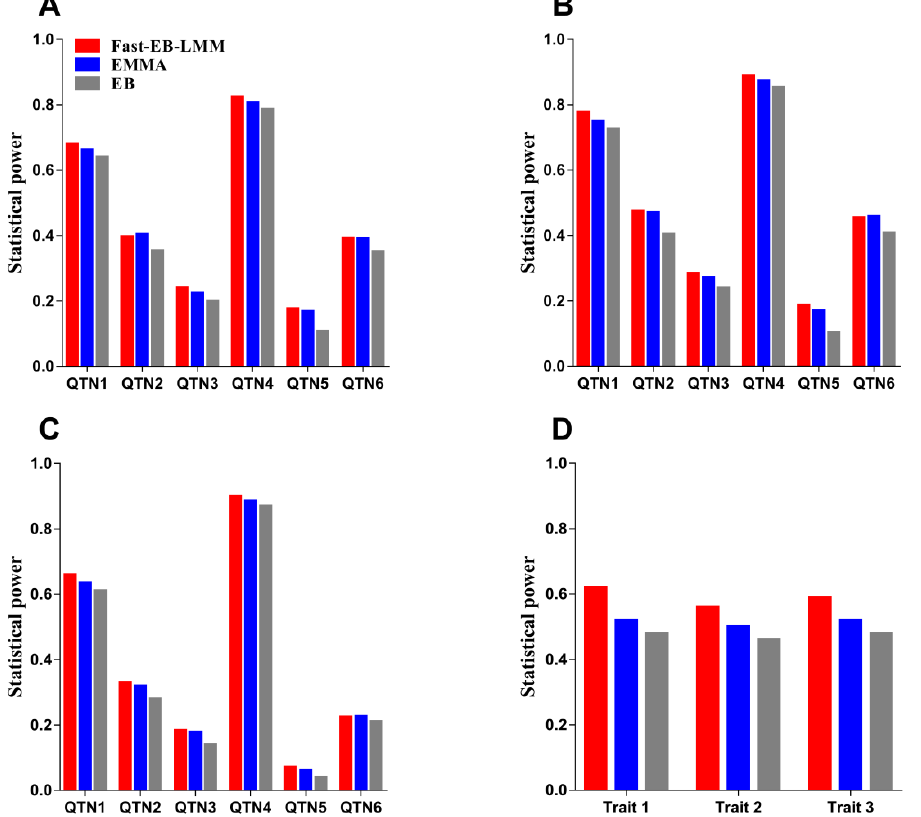
Figure 1. Statistical powers for two di ff erent simulation experiments using the three di ff erent methods (Fast-EB-LMM, EMMA and EB). The heritabilities were set as 0.10, 0.05, 0.05, 0.15, 0.05 and 0.05 for QTN 1–6 in the first simulation experiment and 0.35, 0.35and 0.50 for Trait 1–3 in the second simulation experiment. ( A ) No polygenic background was simulated in the first simulation experiment. ( B ) A polygenic background was simulated in the first simulation experiment. ( C ) An epistatic background was simulated in the first simulation experiment. ( D ) Statistical power comparison in the second simulation experiment.